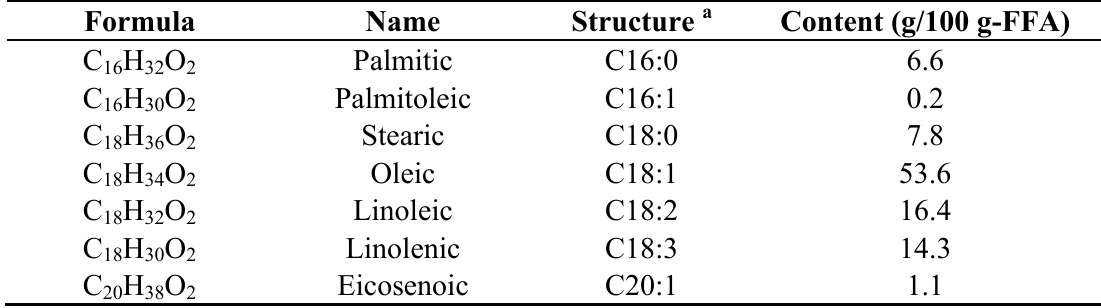
Table 3. Species of free fatty acid (FFA) in the waste cooking oil used in this